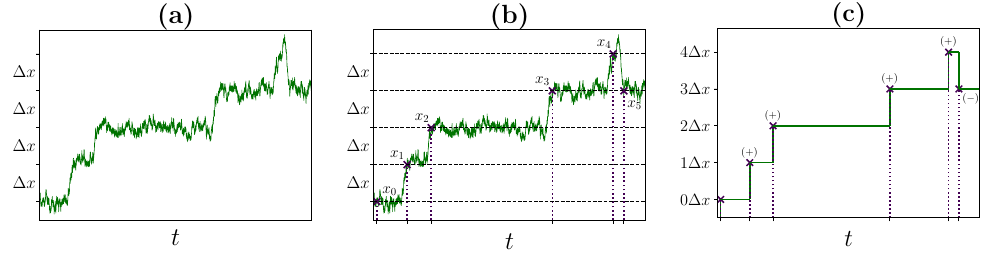
Figure 2. Illustration of the coarse-graining procedure for an exemplary bead trajectory. ( a ) Choice of the reference spacing. Starting from an observed bead trajectory, we choose a value for ∆ x . ( b ) Construction of the effective description. For the chosen ∆ x , we identify crossing events x i along the trajectory. Starting from x i 1 , a crossing event x i corresponds to positive or negative coverage of − ∆ x at a subsequent point later in time. ( c ) Alternative transition-based interpretation. By interpreting positive coverage of ∆ x as a + -transition and negative coverage of ∆ x as a -transition, transitions − can be identified for the observed bead